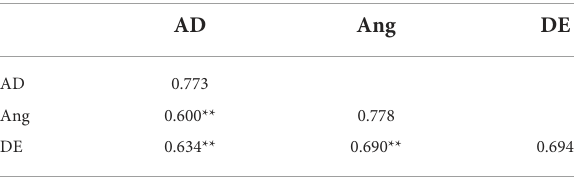
TABLE 5 Discriminatory validity for the ALS-AF ( n =